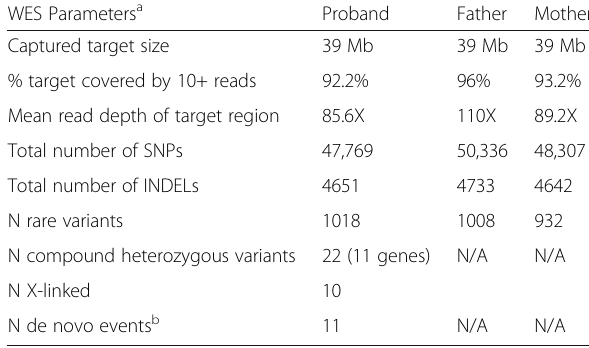
Table 1 NGS quality report summary. Rare variants and X-linked variants are defined as having allele frequencies < 1% in ESP5000 (from NHLBI EVS), 1000G and CG52. Compound heterozygous variants are restricted to non-synonymous variants shared heterozygous with each parent and with allele frequencies of < 1% in each reference database. De novo events are defined as all variants in the IDT ’ s xGen Exome Research Panel target region which are seen in neither parent and are absent from dbSNP, EVS5000, 1000G and were required to have genotype qualities (GATK) > = 20 and read depth > = 10 WES Parameters a